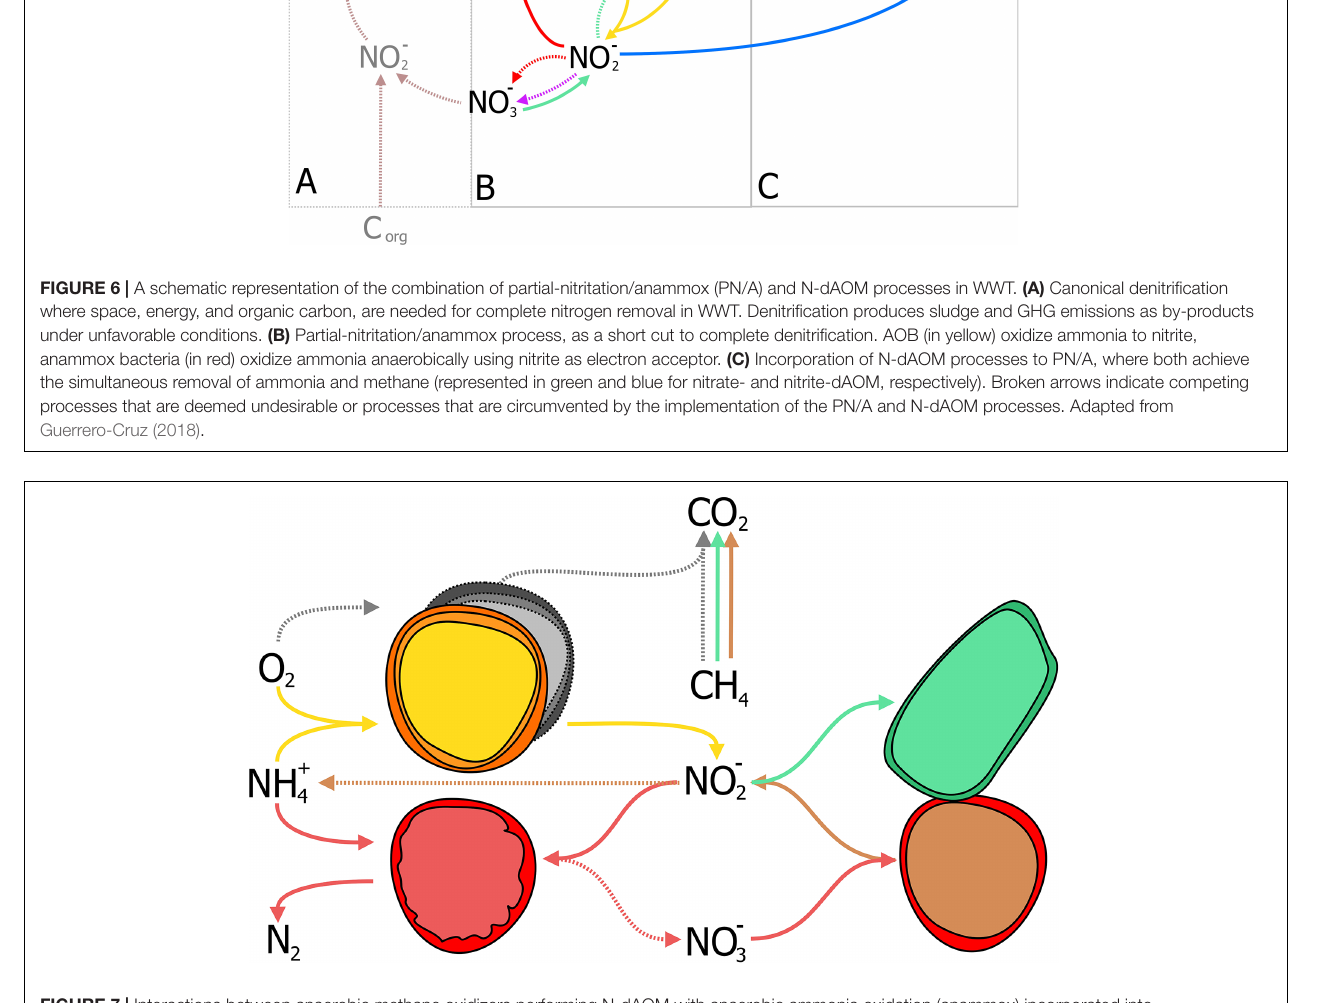
FIGURE 7 | Interactions between anaerobic methane oxidizers performing N-dAOM with anaerobic ammonia oxidation (anammox) incorporated into partial-nitritation systems (PN/A). In existing PN/A systems for ammonia removal, aerobic ammonia oxidizers (AOB, in yellow) oxidize ammonia to nitrite, anammox bacteria (in red) use nitrite to oxidize ammonia to dinitrogen gas, while producing residual nitrate from carbon fixation. “Ca. Methanoperedens nitroreducens” (in brown with red outline) converts nitrate to nitrite as common intermediate while oxidizing methane to carbon dioxide and can produce ammonia. Nitrite either produced by AOB or M. nitroreducens , is used by Methylomirabilis bacteria (in green) for the oxidation of methane to carbon dioxide. Aerobic methane oxidizers (in grey) compete for oxygen with AOB, and can oxidize methane, in competition with anaerobic methane